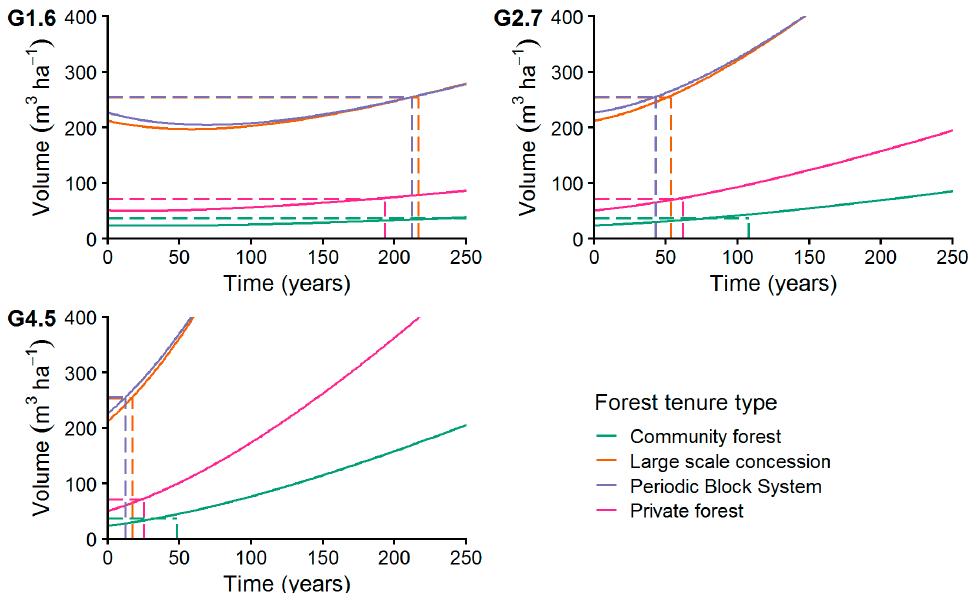
Figure 11. Increment of commercial species volume applying growth levels G1.6, G2.7, and G4.5 with MR = 1% p.a. The dashed lines connect the initial volume before harvesting with the years needed to achieve it after harvesting (recovery time, see Section 2.7.2).